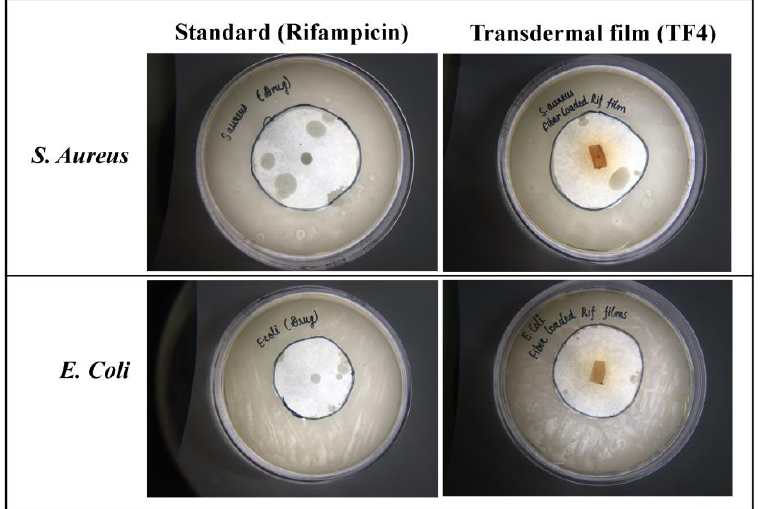
Figure 7. Antimicrobial activity of standard group (Rifampicin) and transdermal film (TF4) against S. aureus and E. coli .